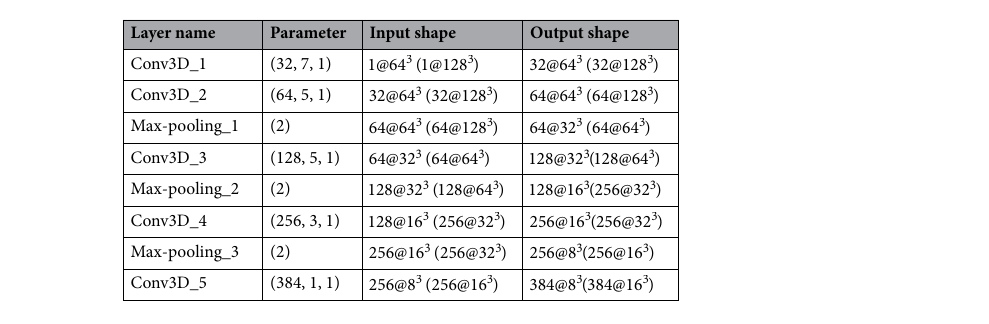
Table 5. Parameters and input/output shape of convolution layer max-pooling